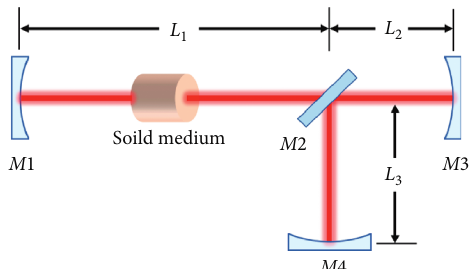
Figure 17: Composite cavity